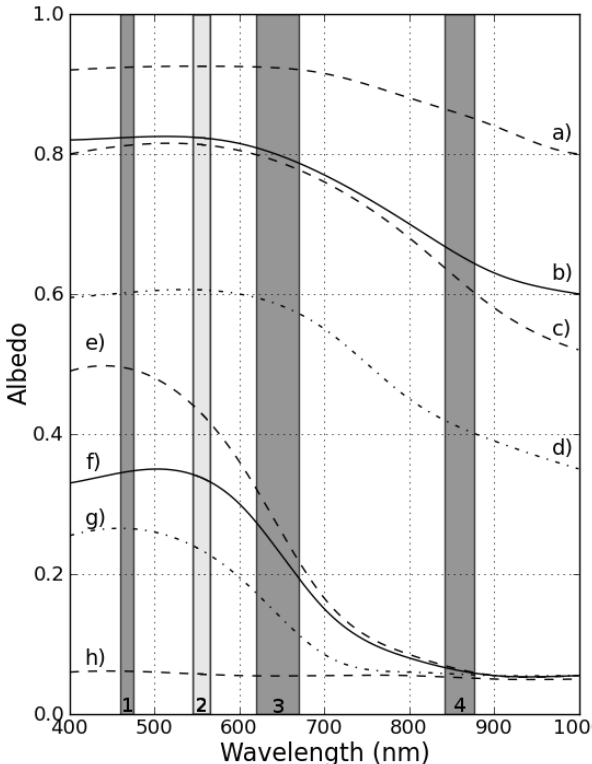
Fig. 2. Spectral albedo values for different surface types on Arctic sea ice: (a) Snow-covered ice (dry snow), (b) cold bare ice, (c) wet snow, (d) melting first year ice, (e) young melt pond, (f) and (g) two types of mature melt ponds, and (h) open water. The gray columns represent the range of the first four MODIS bands. For our study we use the spectral bands 1,3, and 4 (albedo values after Grenfell and Maykut,